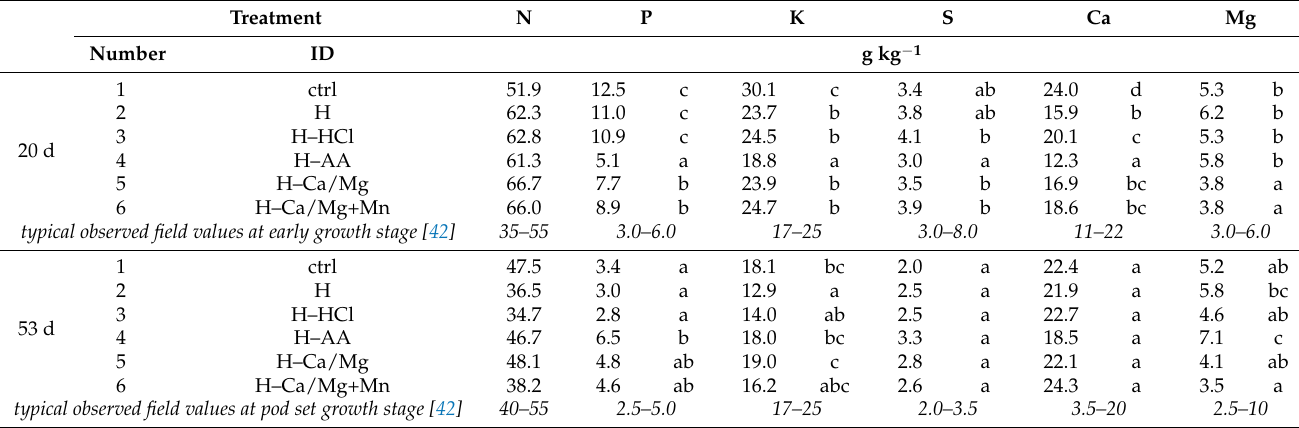
Table 6. Soybean shoot macronutrient concentrations at 20 (growth stage V4–V6) and 53 (growth stage R1–R2) d after planting for a hydroponic nutrition study.